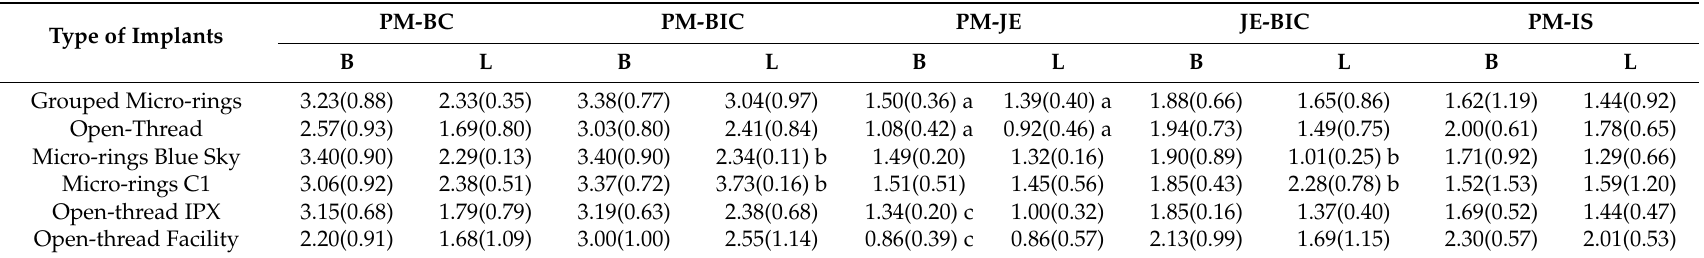
Table 2. Histomorphometric evaluation of soft tissue adaption after 8 weeks healing. Grouped data are presented for each neck design and for implants of similar design (micro-rings compared with open-thread). Results are expressed as mean ± standard